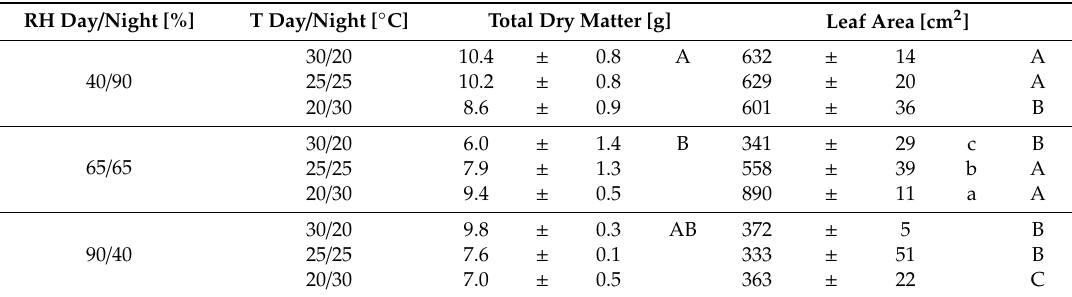
Table 1. Total plant dry matter and plant leaf area at 49 days after sowing after two weeks exposure to varying day and night temperature and RH regimes. Mean values of three replications are presented including standard errors. Small letters indicate di ff erences at p < 0.05 between temperature treatments; capitals indicate di ff erences at p < 0.05 between RH treatments.